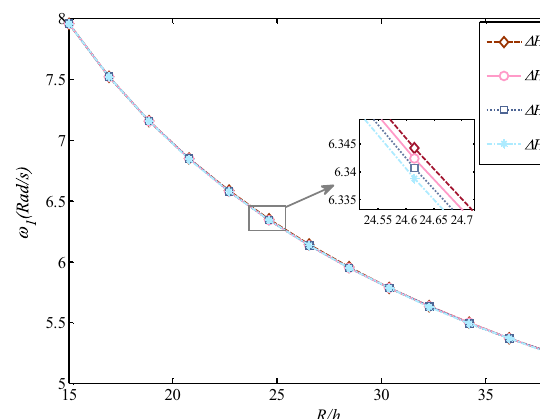
Figure 7: Moisture changes ’ in fl uence on the structure's funda -